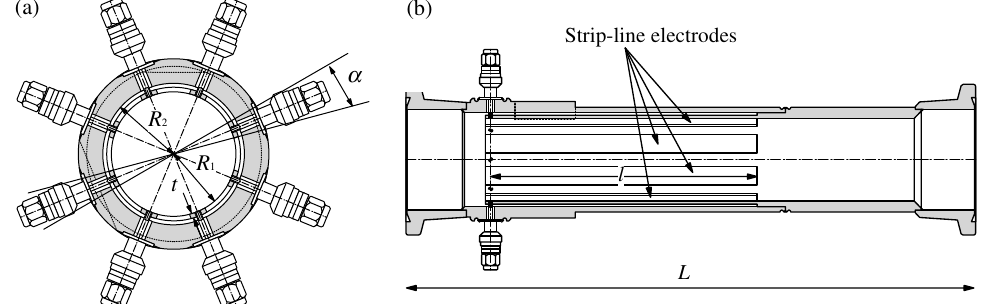
FIG. 2. Schematic cross-sectional drawings [(a) front and (b) side views] of the beam energy-spread